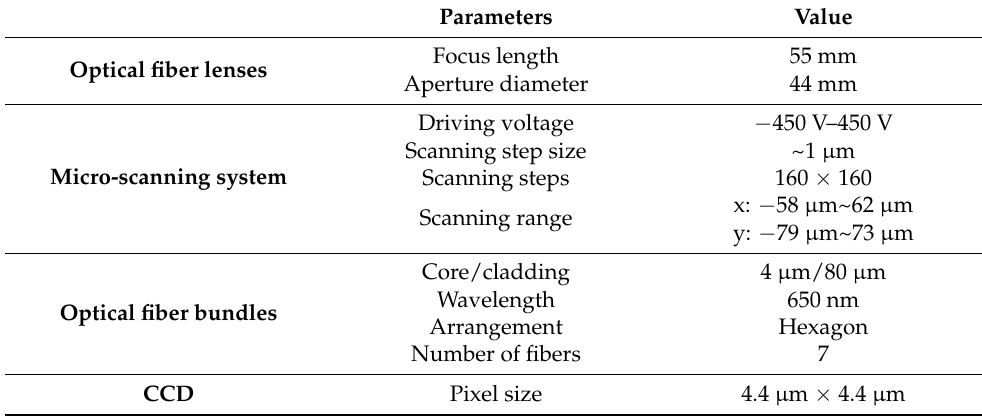
Table 1. Parameters of micro-scanning and direct imaging in the experiment.